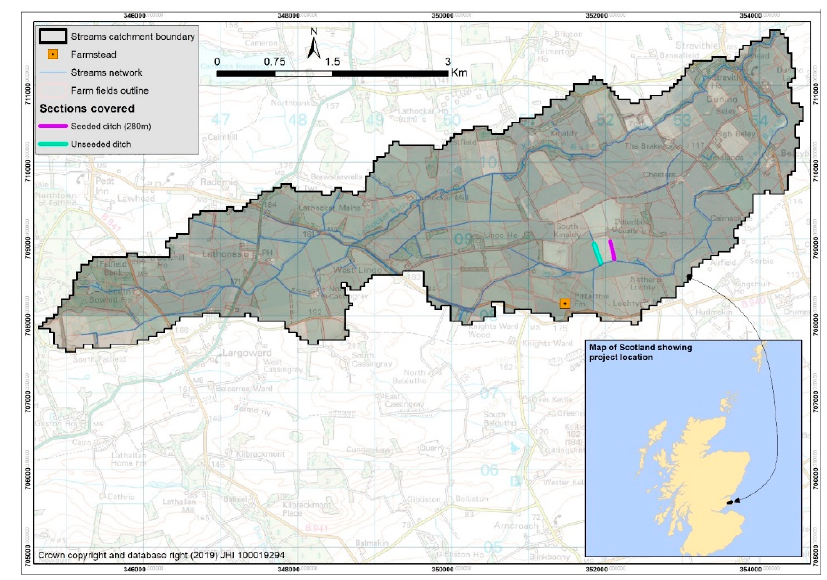
Figure 1. Location of the Pittarthie Farm watercress trial. Grid Reference No. 51505 08136.